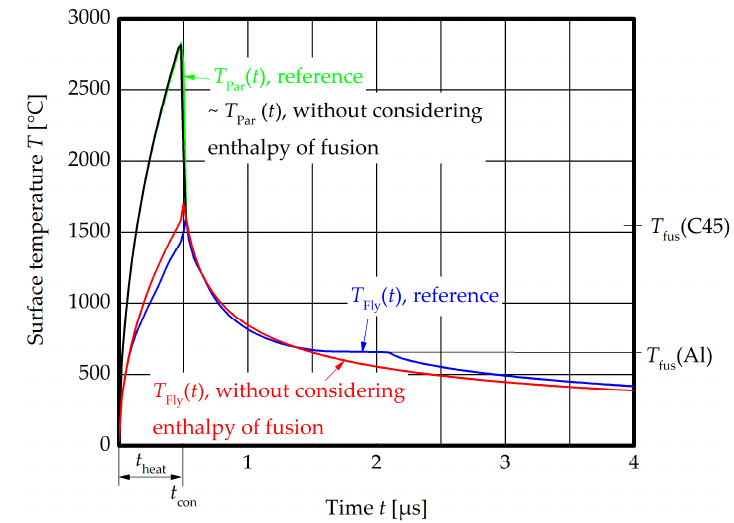
Figure 17. Comparison of T Fly ( t ) and T Par ( t ) for the reference setup (heat quantity at each surface 22,450 J/m 2 , heating time 0.5 µ s, waiting time 0 µ s, flyer material EN AW-6060, parent material C45) with and without considering the enthalpy of fusion.